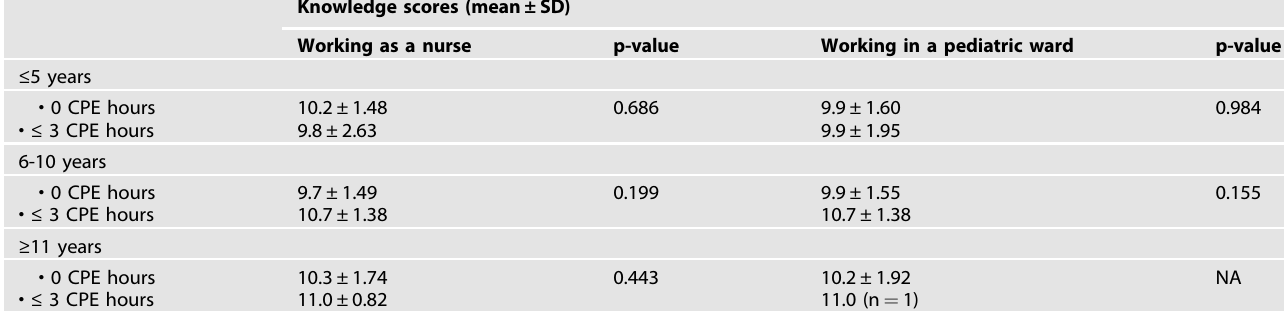
Table 2. Comparison of years of nursing experience and Continuing Professional Education (CPE) hours with overall knowledge score.